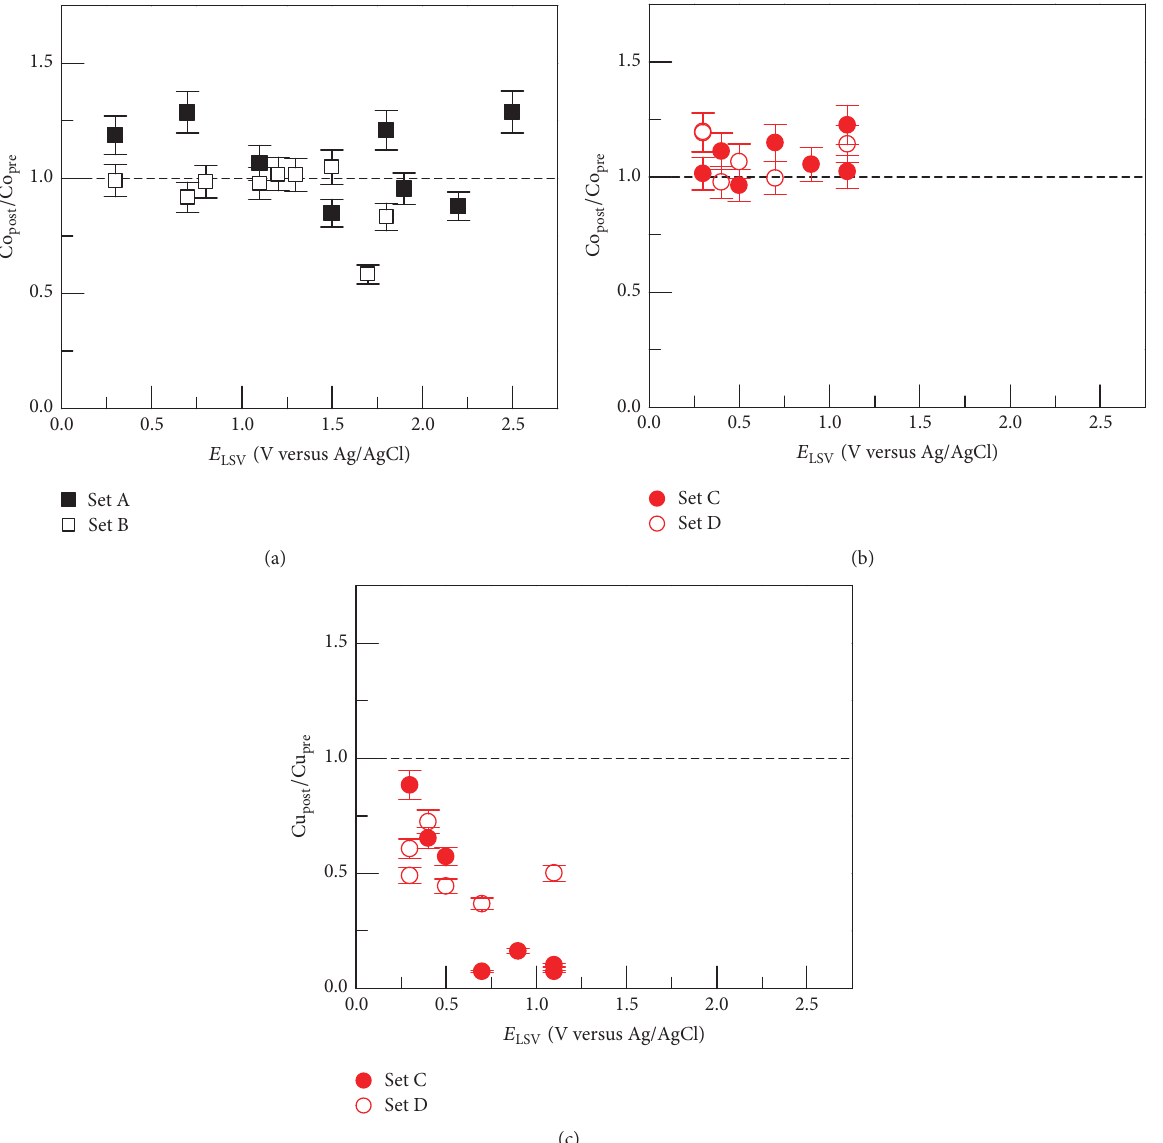
Figure 5: Elemental composition ratios, (a) Co post / Co pre for the samples in Sets A and B, (b) Co post / Co pre for the samples in Sets C and D, and (c) Cu post / Cu pre for the samples in Sets C and D, as a function of 𝐸 LSV . The dotted lines correspond to ratios equal to 1, indicating no change in composition for that